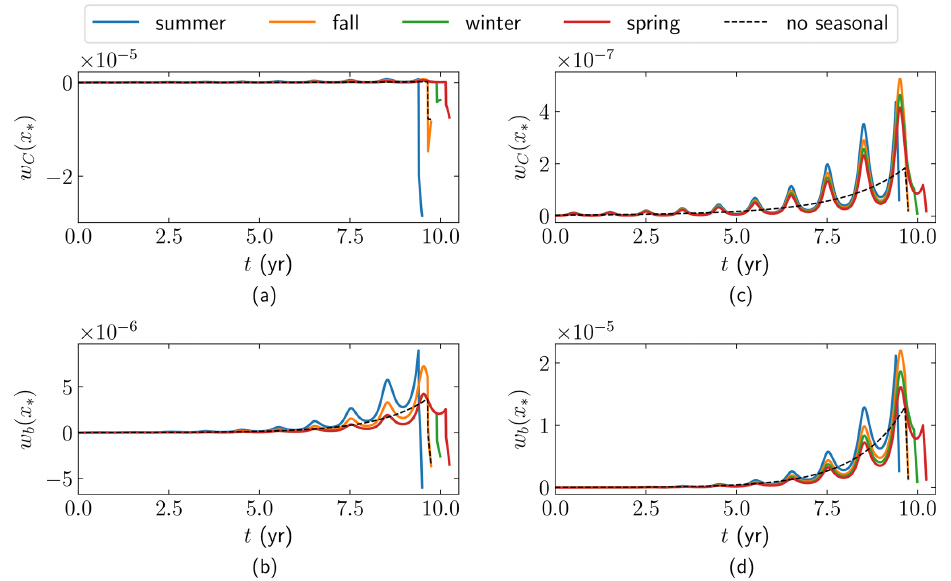
Figure 9. The adjoint weights at x ∗ in the four seasons of the 10th year with seasonally varying friction coefficient. The black dashed line is a reference solution without seasonal variations which is observed at t ∗ = 9 . 75. (a) w C for the observation of u . (b) w b for the observation of u . (c) w C for the observation of h . (d) w b for the observation of h